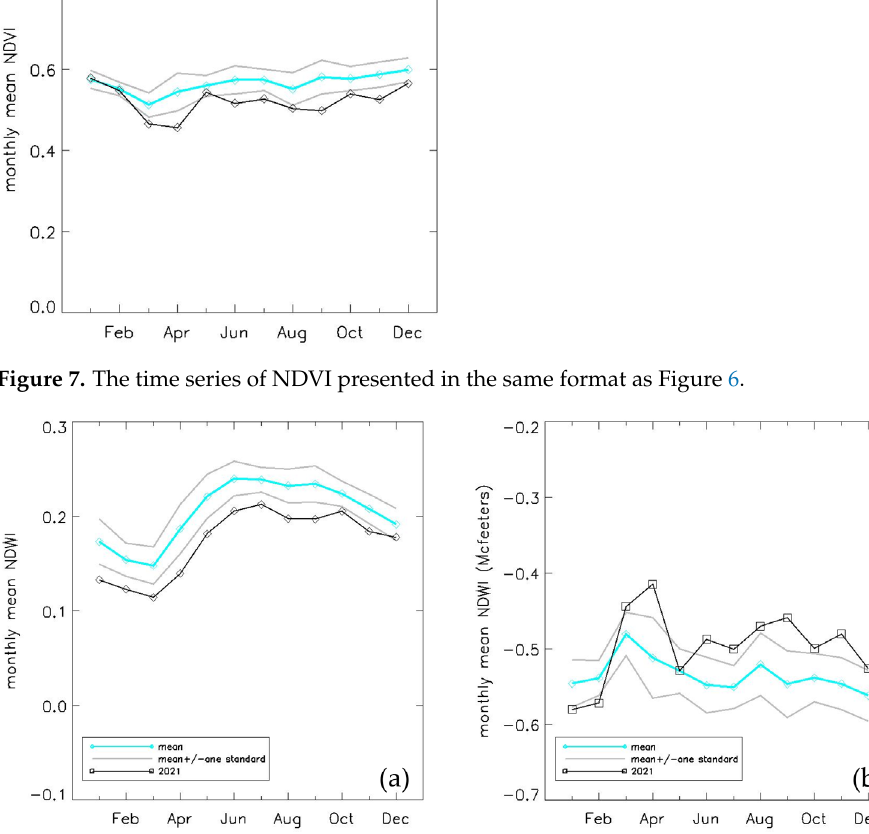
Figure 8. The time series of ( a ) the [4] version of NDWI and ( b ) the [20] version of NDWI. Presented in the same format as Figure 6.